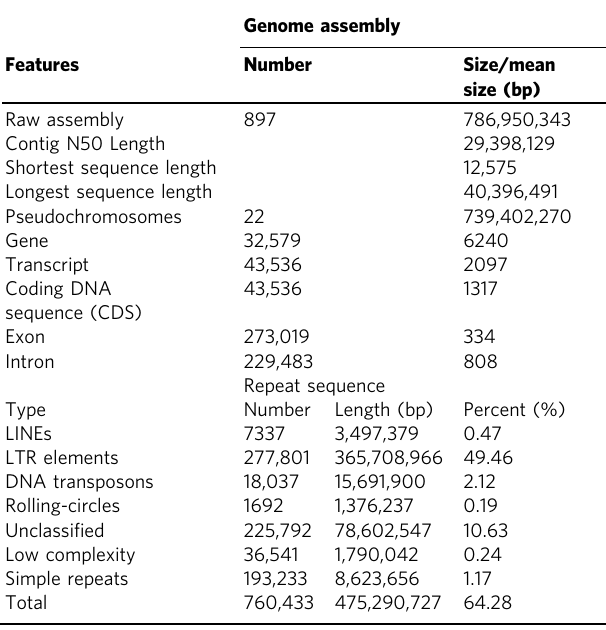
Table 1 Statistics of the Chinese tallow tree (CTT) genome assembly and